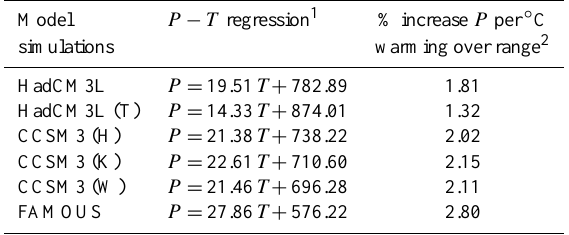
Table 2. Summary of relationships between global surface air tem- perature and precipitation rate. 1 T : SAT ( ◦ C); P : global precipi- tation (mmyr − 1 ). 2 Precipitation sensitivity is calculated over the range of 15–30 ◦